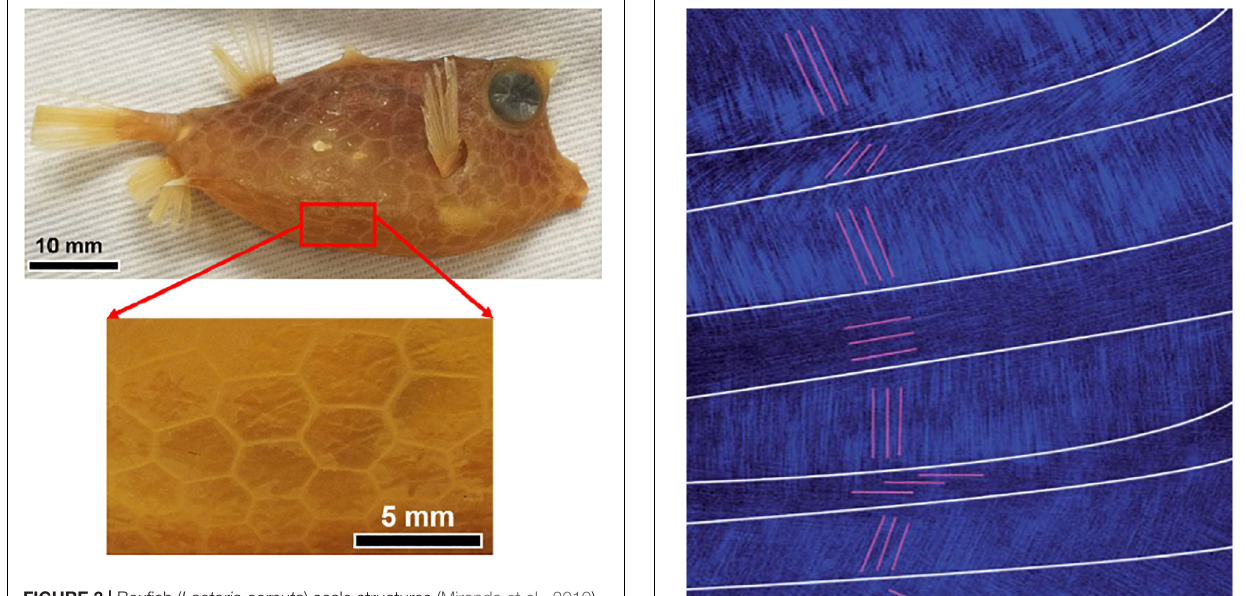
orientation of each fiber in each of the eight regions in red color (Feng et al., 2020).